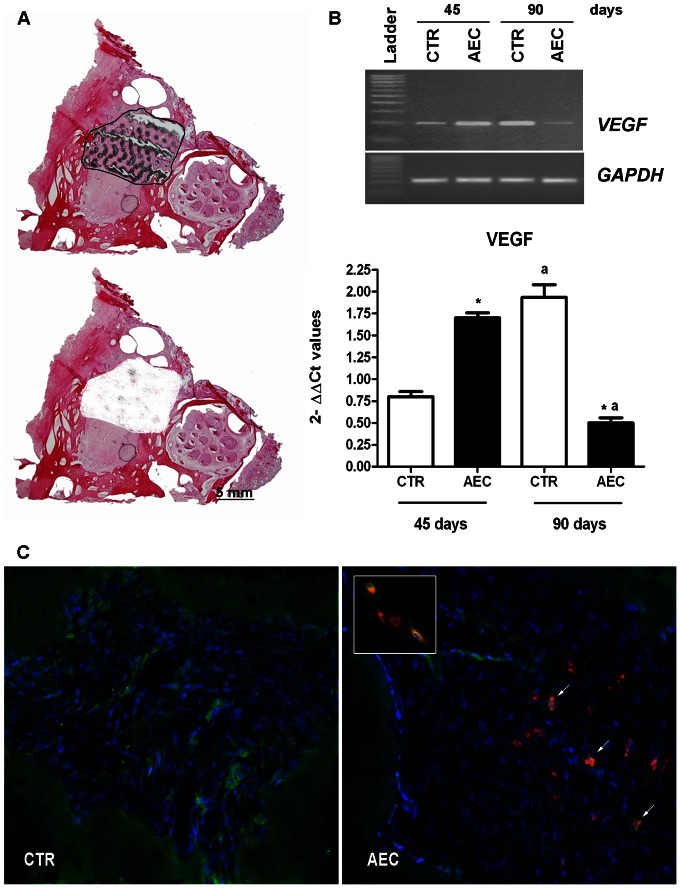
VEGF expression in grafted sinuses.A) Laser capture micro dissection (LCM) isolation of the implanted area from sinus explant. The top image shows an example of cryosection stained with HE where a black line delimits the implanted area that must be isolated by using LCM technique. The bottom image shows the same section after the implanted site was removed by LCM. Scale bar = 5 mm. B) VEGF mRNA expression. Top: image is a representative example of VEGF amplification. Bottom: quantitative VEGF analysis expression performed in real time PCR (values are mean of 3 replicates ±SD). *indicates values significantly different between CTR and oAEC groups within the same time interval (p<0.01), a indicates values significantly different in CTR or oAEC sinuses between the two time intervals (p<0.01). C) VEGF protein distribution in grafted sinuses 90 days after p.i.. Two representative images displaying the VEGF protein (green fluorescent signal) within the implanted area of a CTR (left image) and oAEC-treated sinuses (right image) explanted 90 days p.i. The nuclei are counterstained with DAPI in bleu and PKH26 labeled cells are visualized by the red fluorescence. Arrows indicate oAEC transplanted cells expressing VEGF (merge = orange fluorescence). Scale bars = 40 µm. The small box in the corner shows a representative example of VEGF expressing oAEC before grafting. The VEGF content of PKH26 labeled oAEC were analyzed on plated cultured cells. The merged orange fluorescence indicates the co-presence of PKH26 dye (red fluorescence) with the Alexa Fluor488 conjugated secondary antibody (green fluorescence). Scale bar = 60 µm.